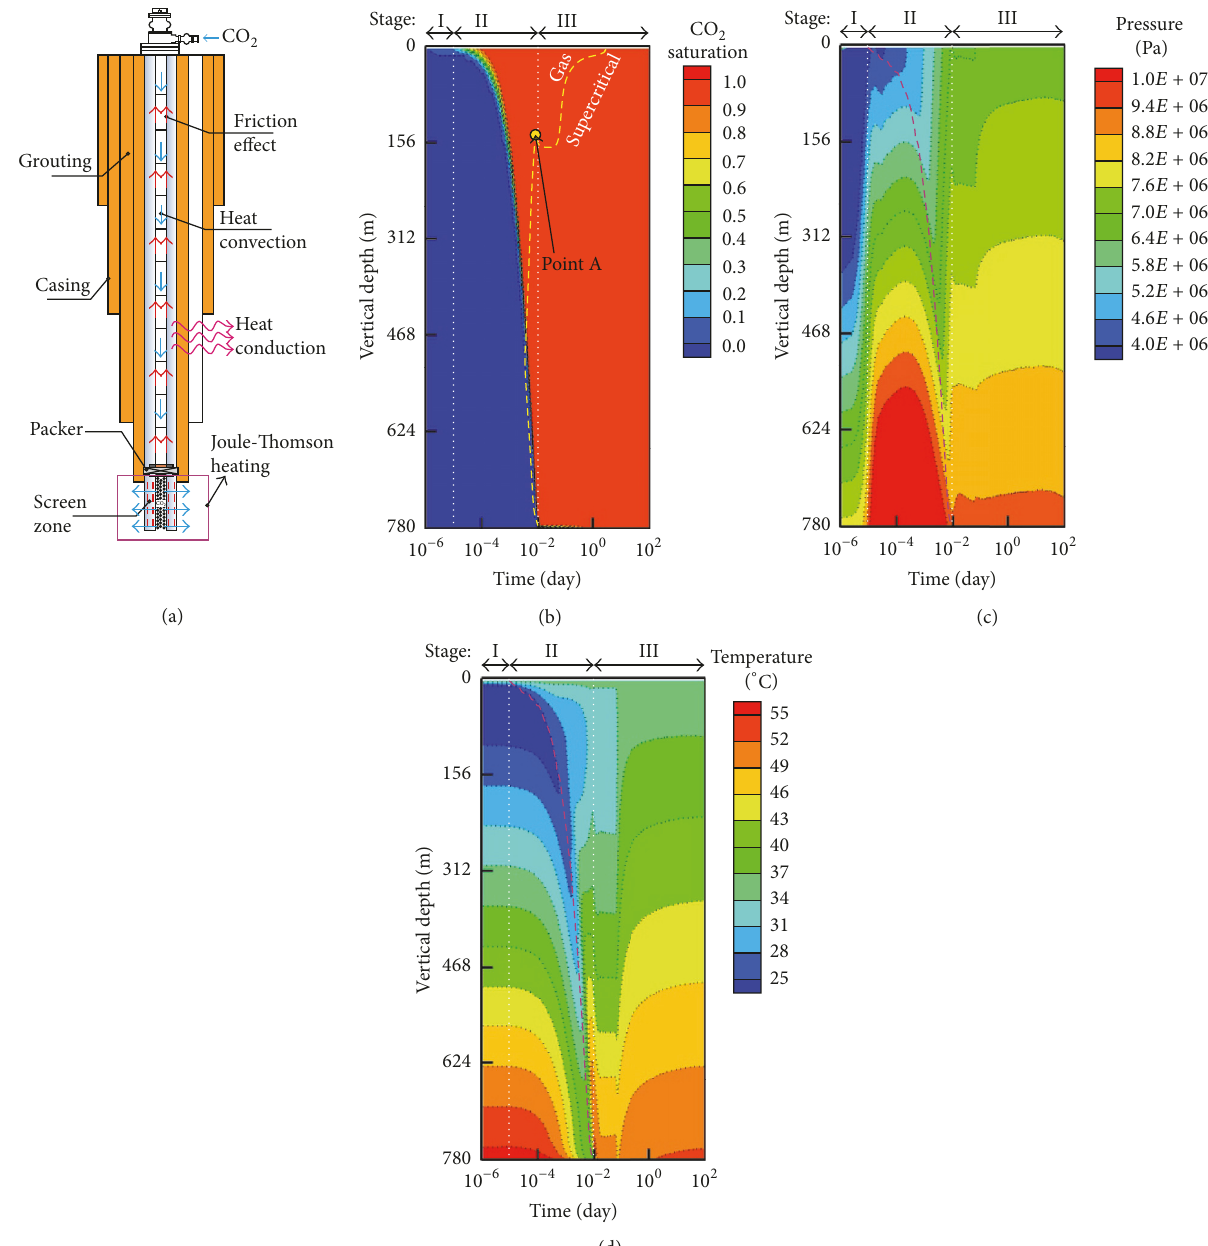
Figure 2: Changes in thermophysical properties of CO 2 within the wellbore during 100 days; (a) a schematic diagram delineating CO 2 transport within the wellbore and associated thermal effects; profiles for (b) CO 2 saturation [-], (c) pressure [Pa], and (d) temperature [ ∘ C]. The two white dotted lines define the initiation of each different stage while injected CO 2 is displacing the brine in the wellbore (1.2 × 10 −5 (=1sec) and 1.2 × 10 −2 (=17.3min)). The yellow dashed line in (b) represents the interface between gaseous and supercritical CO 2 phase.